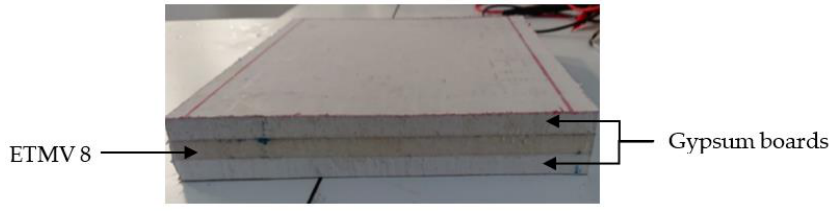
Figure 3. View of the ETMV8 Sample-gypsum board used for experimental tests.